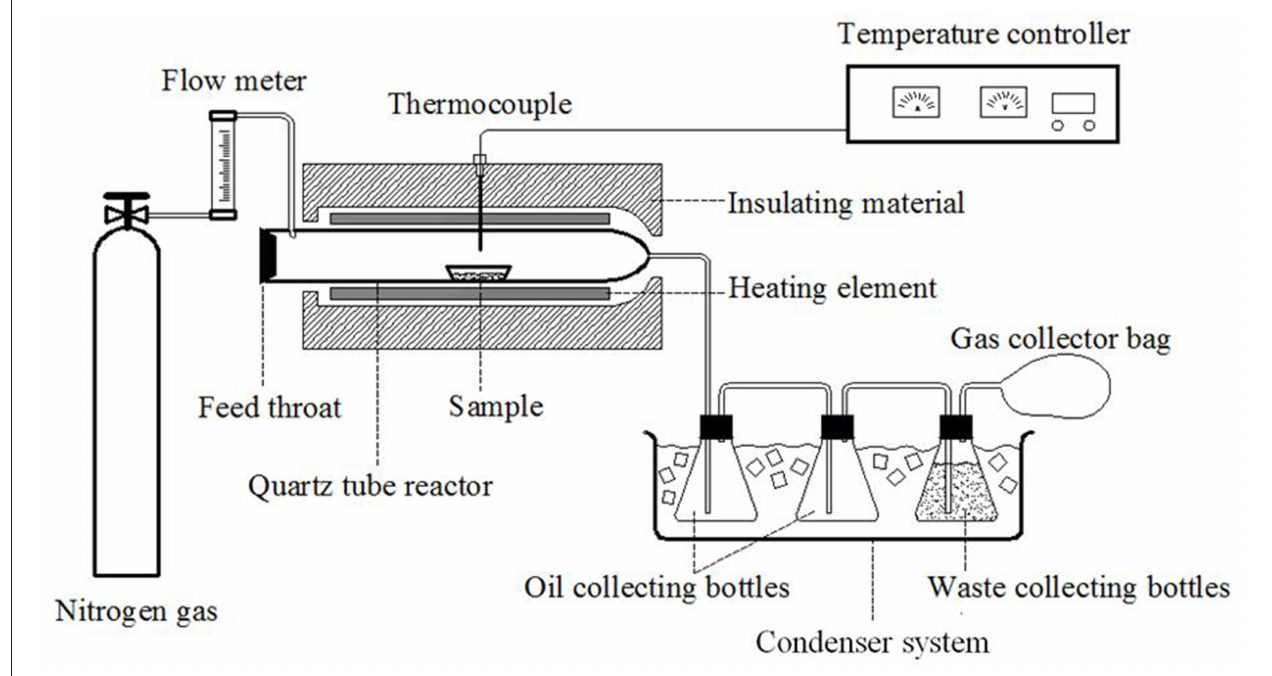
FIGURE 1 | Fixed bed tubular furnace.